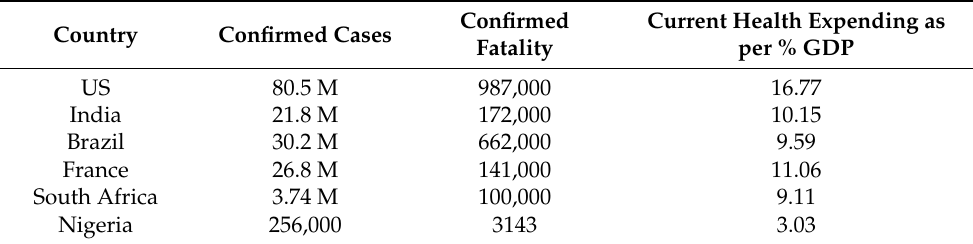
Table 5. Current heath expenditures, COVID-19 confirmed cases, and deaths in selected countries as of 15 April